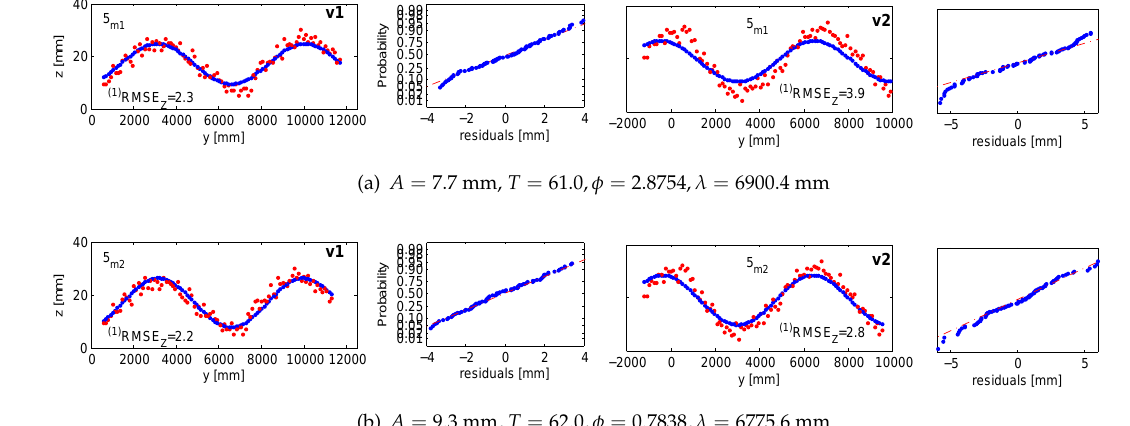
Figure 17. Accuracy 1 validation results in the fifth measurement series for m 1 in ( a ) and m 2 in ( b ), compared against the response of vt 1 and vt 2. Ground truth in red; fitted wave model in blue. The normal probability plots are in even columns.